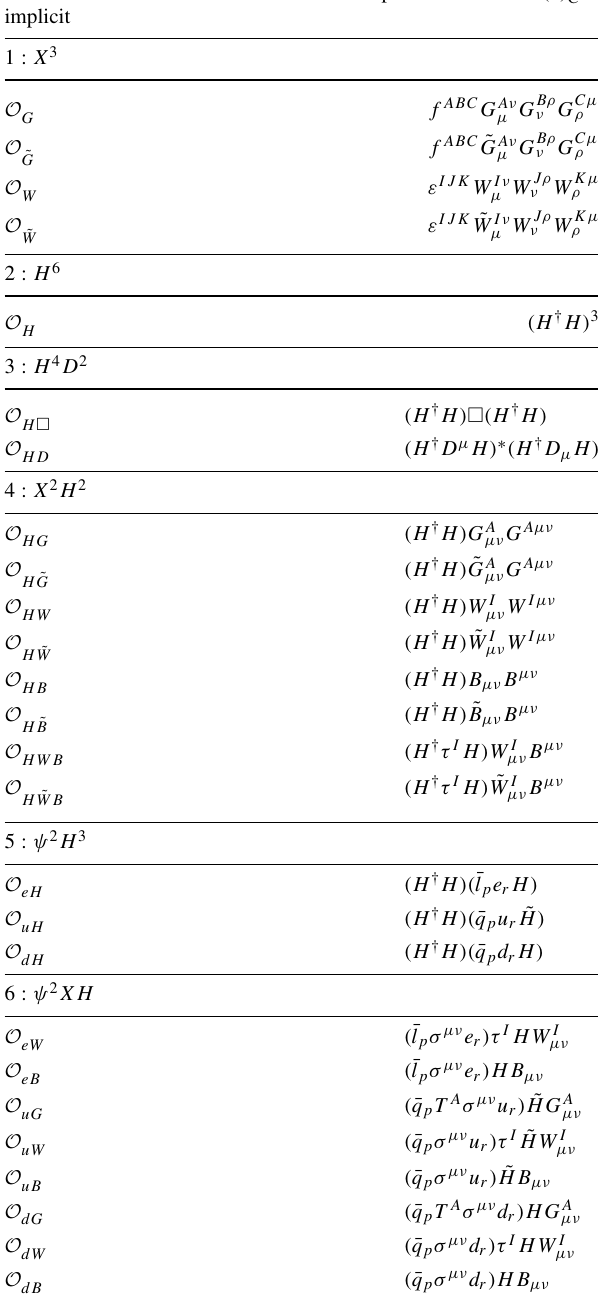
Table 2 The 59 independent dimension-six operators built from SM fields which conserve baryon and lepton number. p , r , s , t are fermion flavour indices, j , k are indices in the fundamental representation of SU ( 2 ) W , I , J , K ( A , B , C ) are indices in the adjoint representation of SU ( 2 ) W (SU ( 3 ) C ) and greek letters ( μ,ν ... ) are Lorentz indices. Contraction of indices in the fundamental representation of SU ( 3 ) C